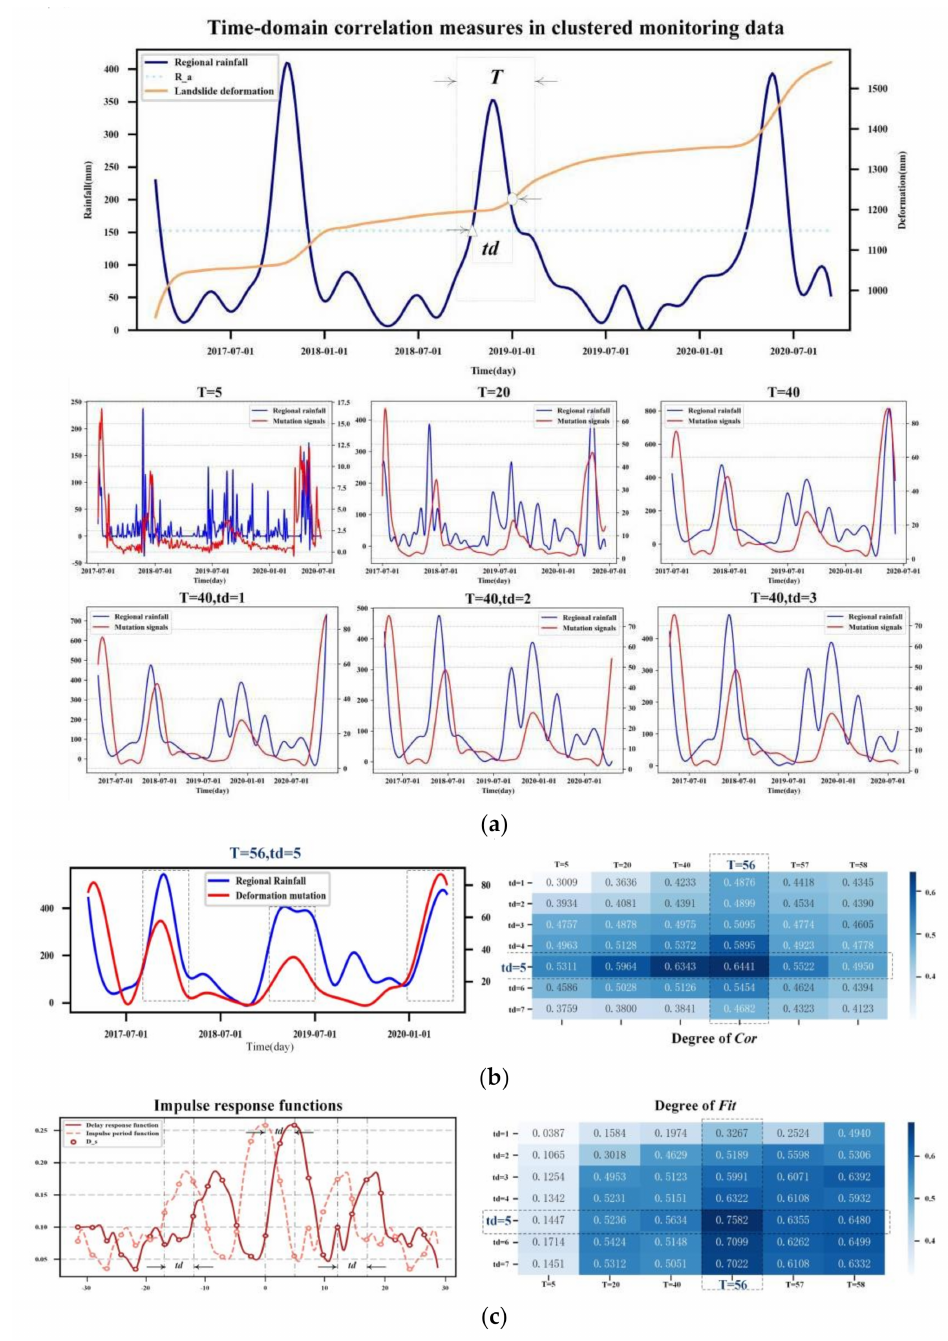
Figure 8. Map of the results of the test using the time-domain correlation quantitative analysis model at landslide site GDA10068. ( a ) This figure illustrates the process of monitoring signals for period clustering using the time domain correlation measure described and the signal time shifting. The correlation measure Cor is also measured quantitatively. ( b ) This figure shows the quantitative calculation of the signal after the clustering and time-shifting operations. The value of Cor tells us the optimal T and td (dark blue). ( c ) Response function construction and quantitative calculation results for correlated signals. The value of Fit tells us the optimal T and td (dark